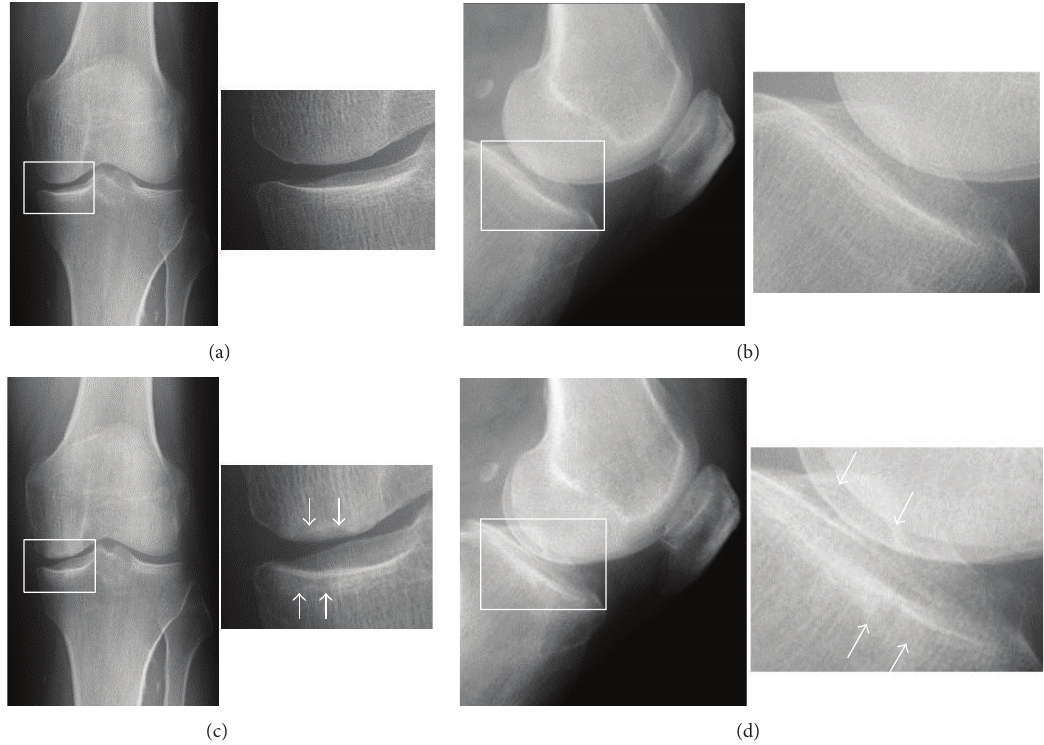
Figure 1: Plain initial (a) frontal and (b) lateral radiographs, showing slight subchondral bone sclerosis on the tibial medial condyle, but no evidence of radiolucent lesions or joint space narrowing. (c) A frontal radiograph and (d) its enlarged view, taken 3 months after the first evaluation, showing a radiolucent oval shadow in the subchondral areas of the weight-bearing portions of both the MFC and MTP, surrounded by a sclerotic halo